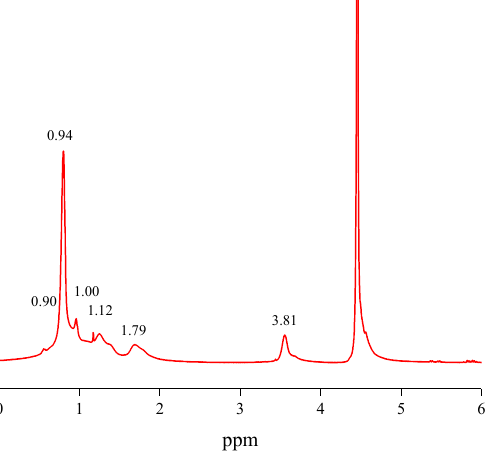
Figure 2. NMR for PNBAM. Figure 2. NMR for